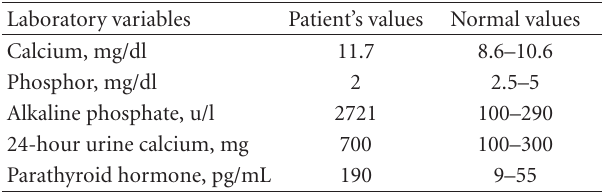
Table 1: Laboratory data of patient with their related normal range.